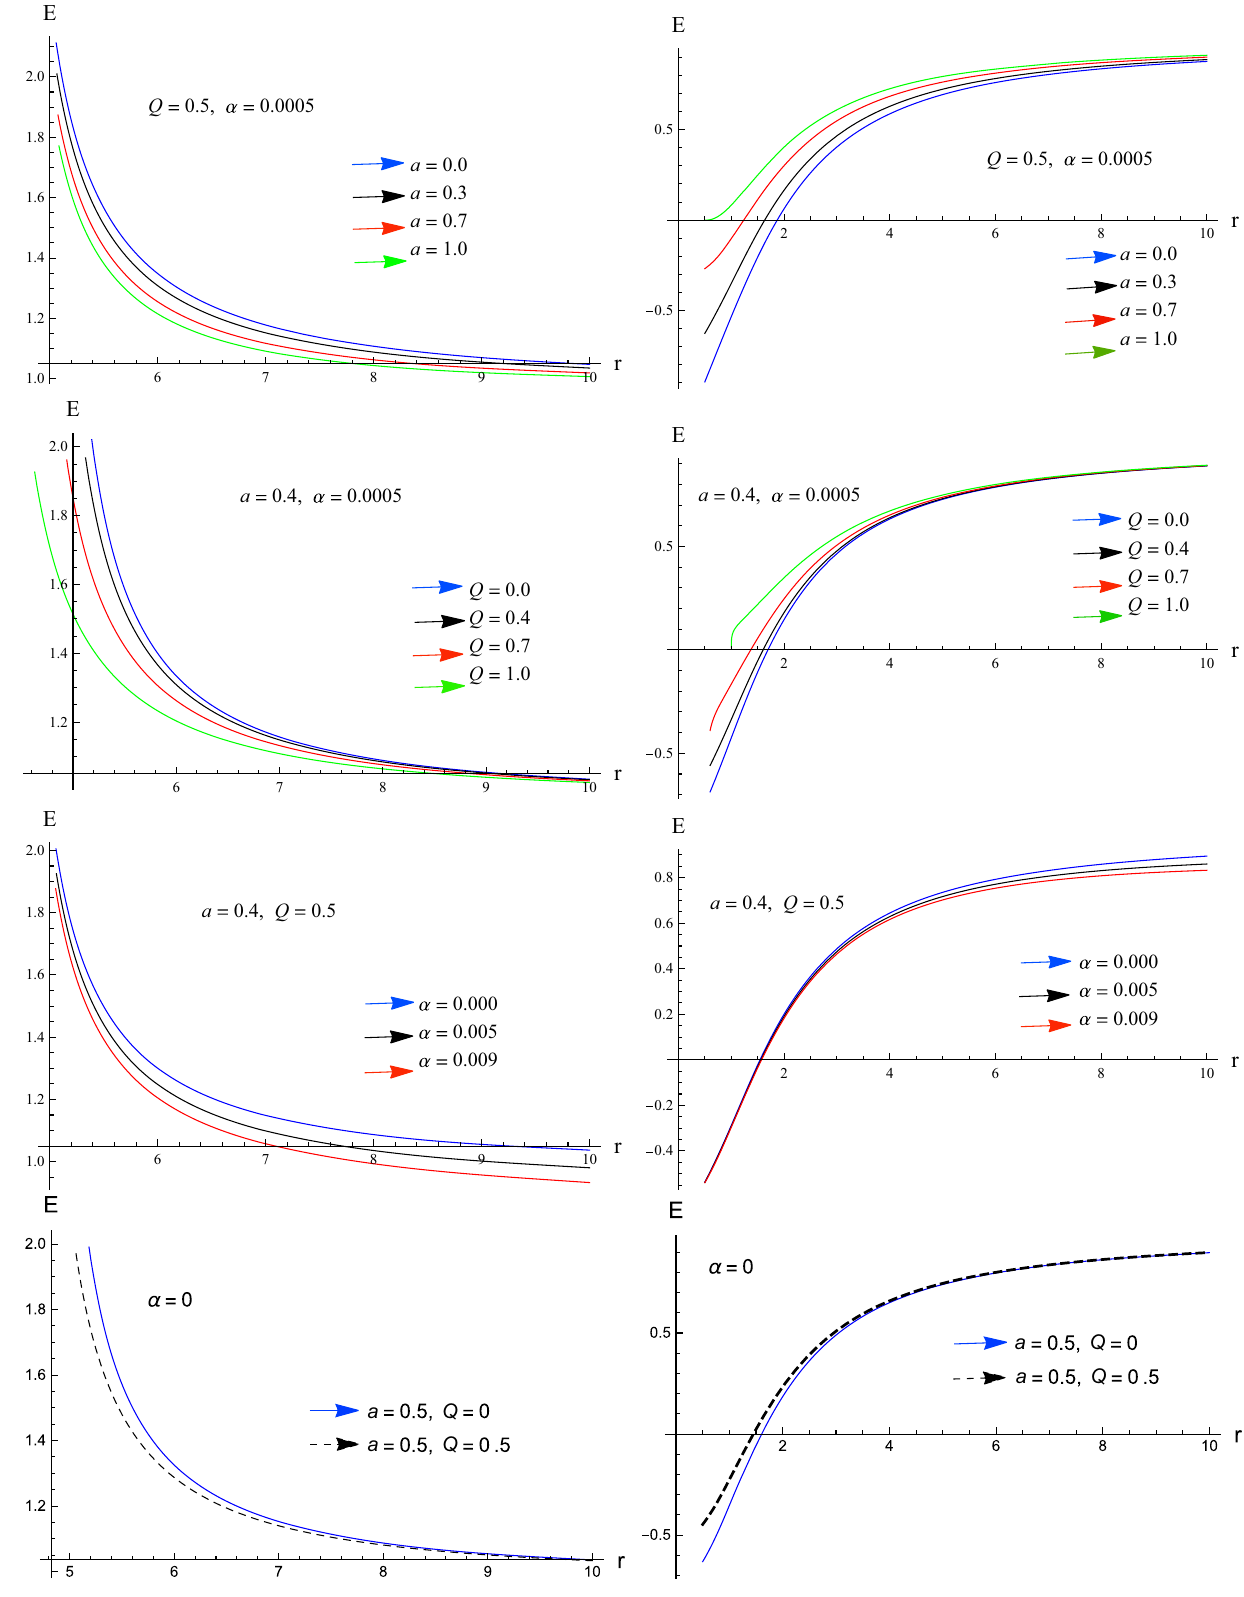
Fig. 1 Plots of energy of a particle as a function of r (left for direct orbits and right for retrograde orbits). Here, the ascending and descending parts corresponds to stable and unstable